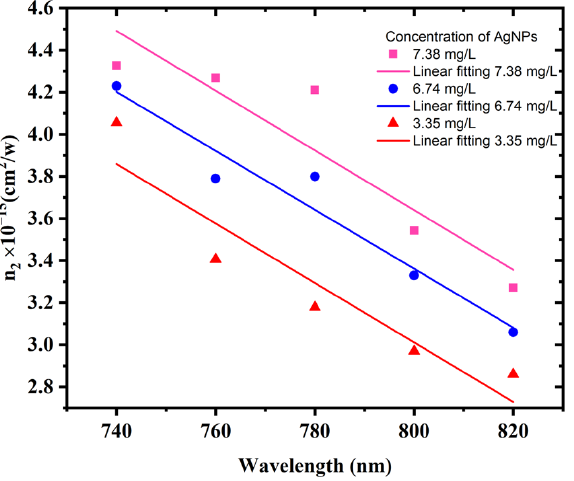
Figure 11. Variation of n 2 as a function of excitation wavelength at different AgNP concentrations.